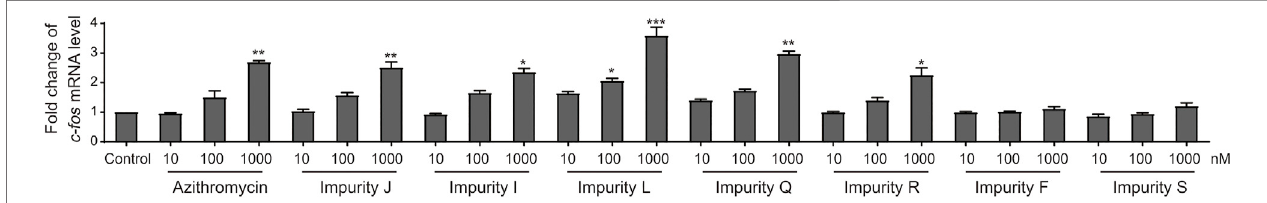
FIGURE5| AzithromycinimpuritiesJ,I,L,Q,R,F,andSpromotetheexpression human c-fos geneinL02cells.Thelevelofhuman c-fos mRNAweredetected by qRT-PCR analysis in each treatment groups. Control, vehicle-treated group with 0.1% DMSO, * indicates p < 0.05, * indicates p < 0.01, *** indicates p < 0.001. All statistical data are represented as mean ± SD ( n = 3).